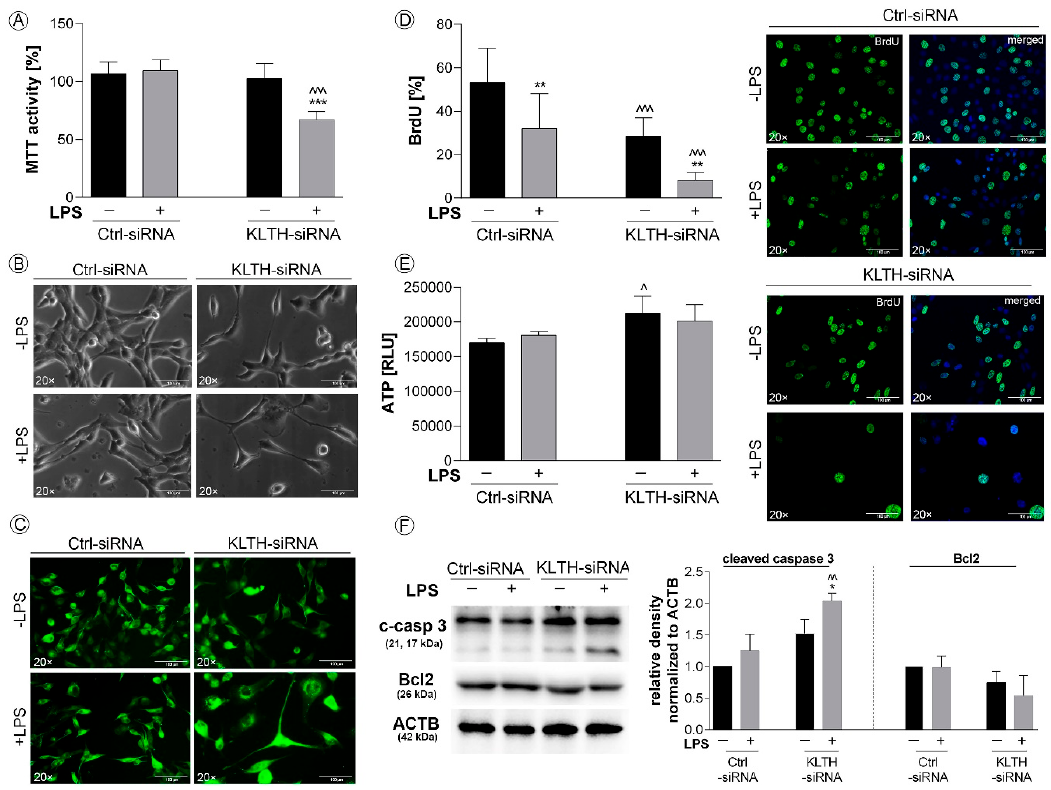
Figure 2. Klotho-depleted HT-22 hippocampal neuronal cells are sensitive to LPS stimulation. The cells were transfected, treated for 48 h with LPS and then, the following parameters were controlled: